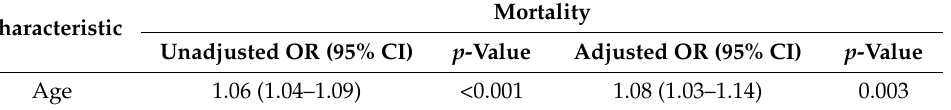
Table 3. Univariate and multivariate analysis of factors predictive of mortality in COVID-19 patients.